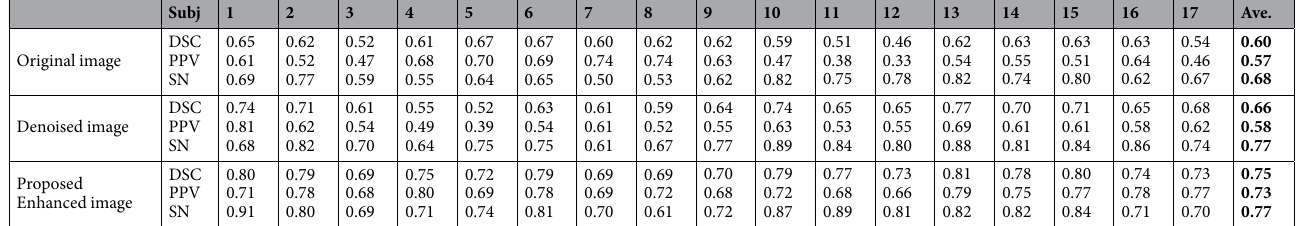
Table 2. Segmentation accuracy of the random forest method on the original 7 T MR images, the denoised images, and our enhanced and denoised images.